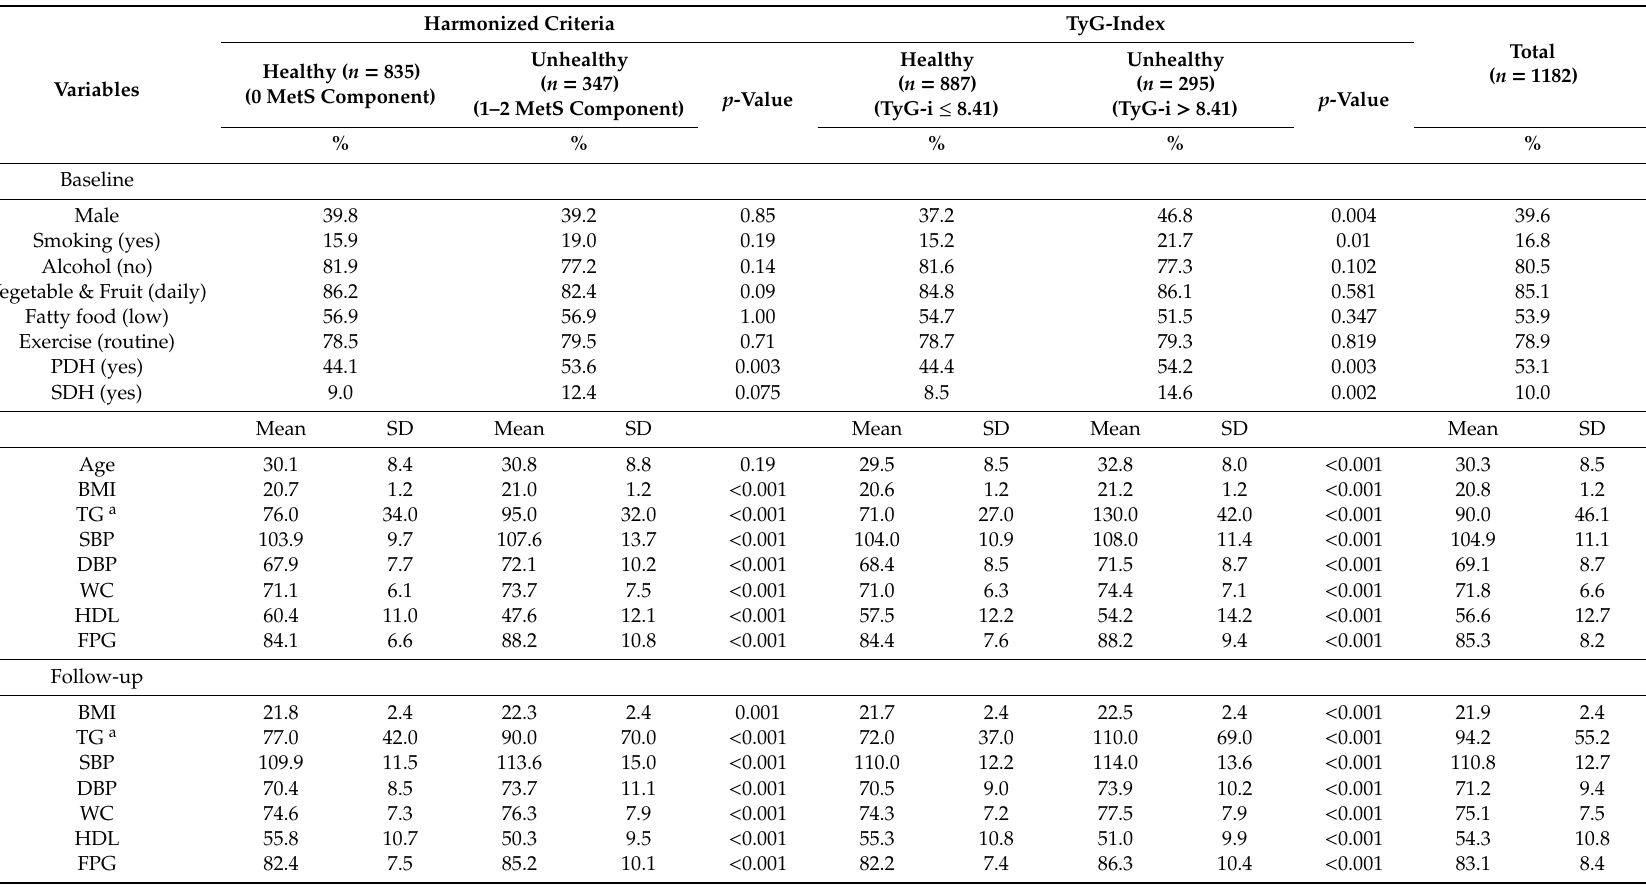
Table 1. Baseline and follow-up